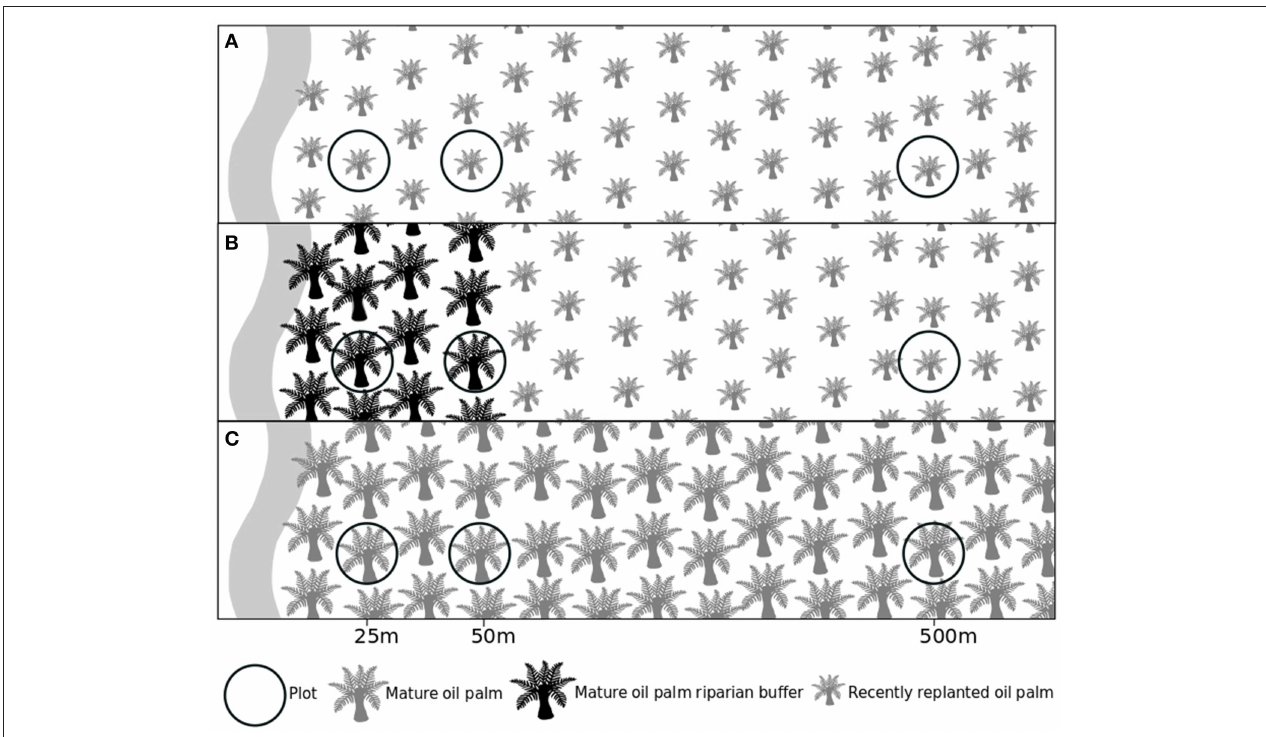
FIGURE 1 | Diagram of sampling sites. Black circles represent plots positioned along a transect running perpendicular to the waterway. (A) Replanted oil palm; (B) Replanted oil palm with a mature oil palm riparian buffer; and (C) Mature oil